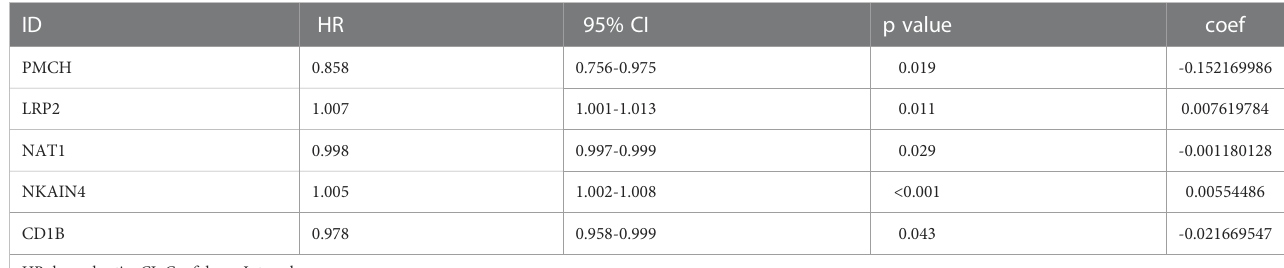
TABLE 2 LASSO-Cox